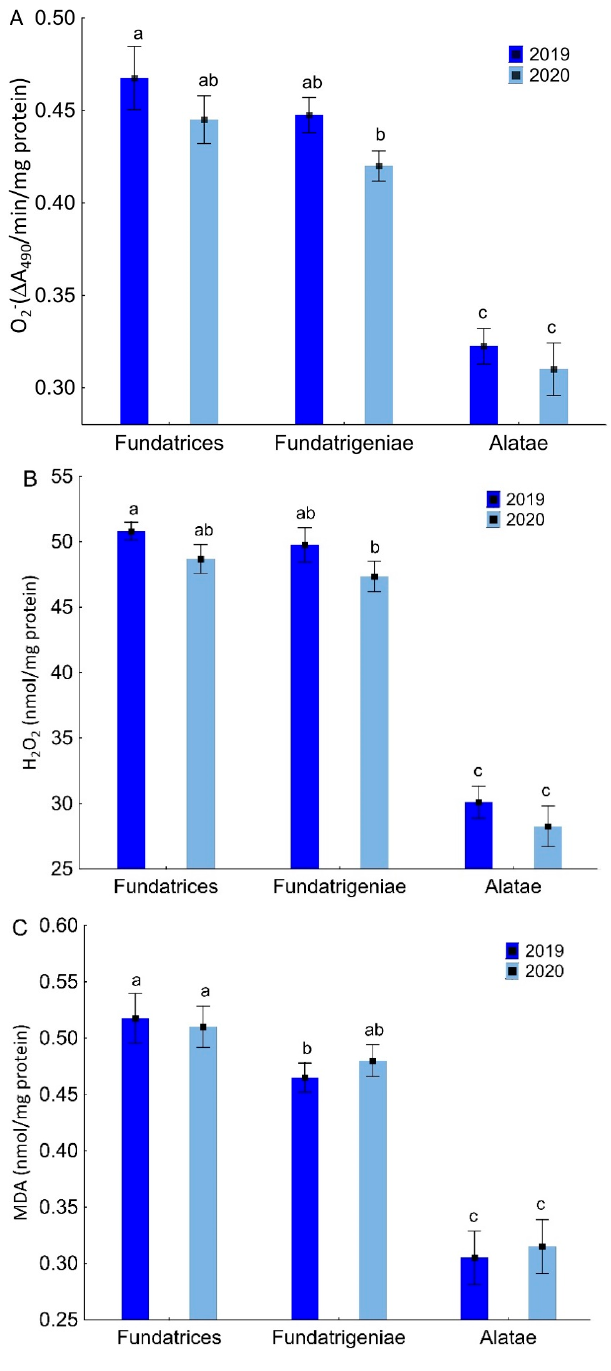
Figure 2. Superoxide anion (O 2 ¯) ( Δ A 490 /min/mg protein) ( A ), hydrogen peroxide (H 2 O 2 ) (nmol/mg protein) ( B ) and malondialdehyde (MDA) content (nmol/mg protein) ( C ) in various morphs of A. fabae on V. opulus (means ± SD; n = 4). Different letters denote significant differences (one–way ANOVA; Tukey’s test; p < 0.05).